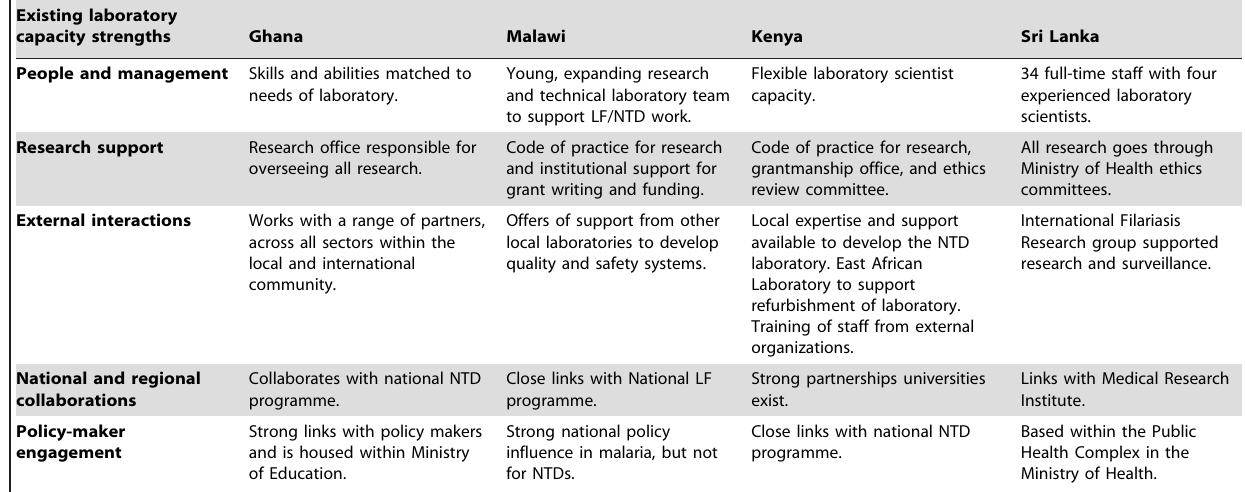
Table 4. Comparison of existing strengths in laboratories included in our